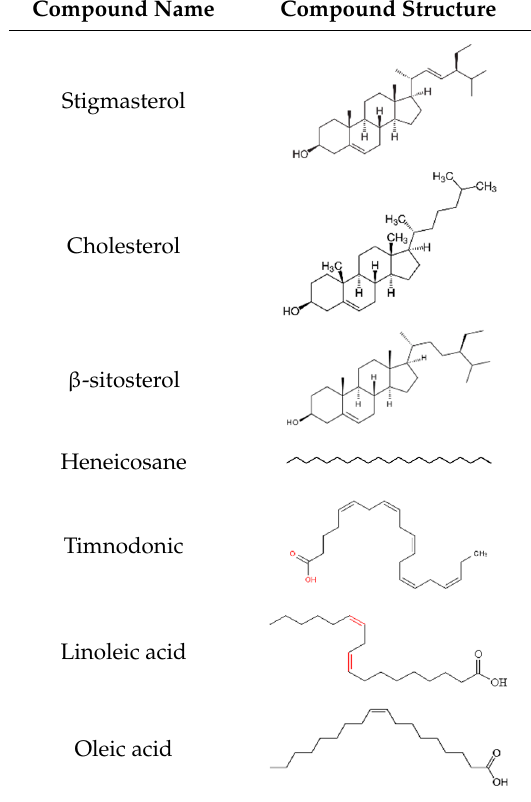
Table 4. The chemical composition of ASMS.